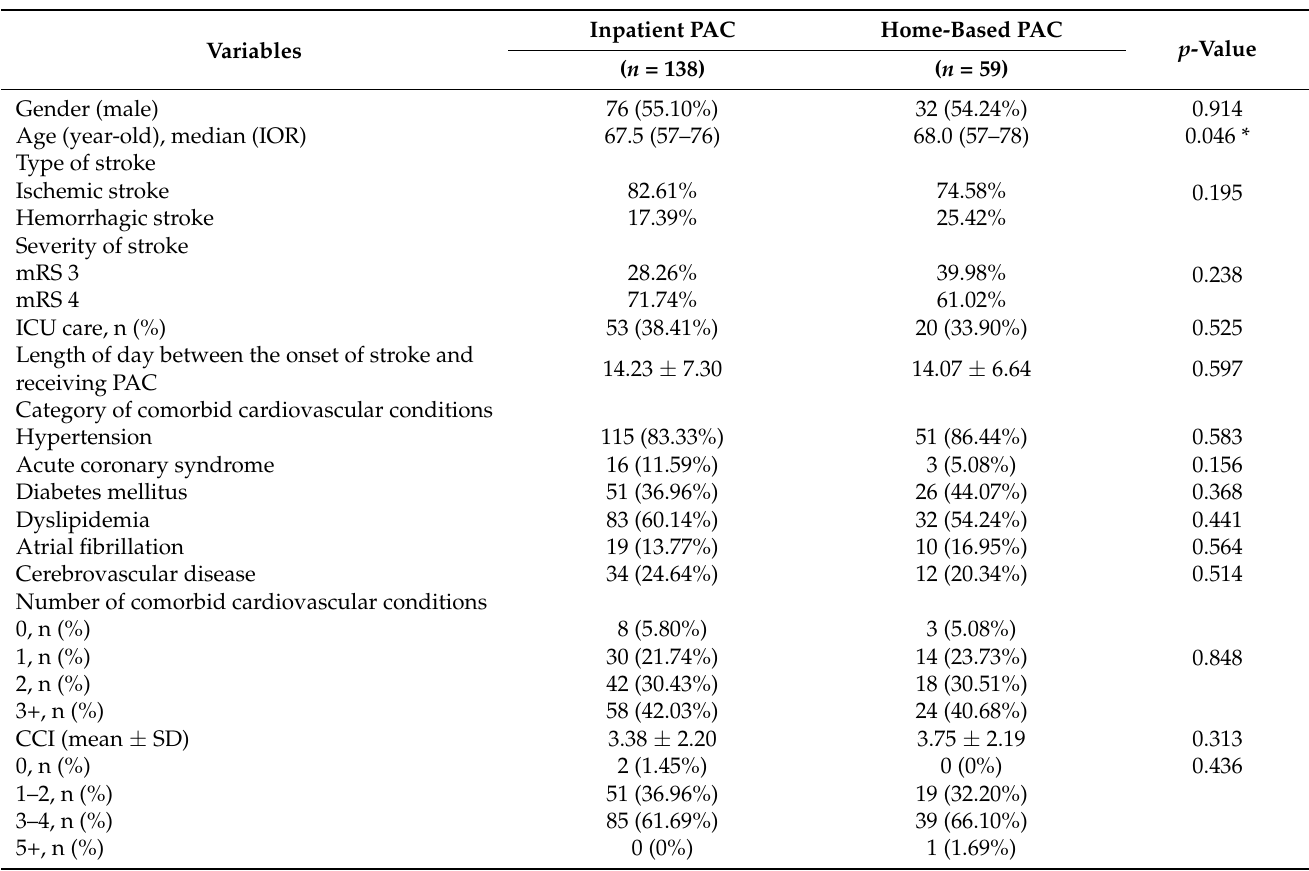
Table 1. Comparison of baseline demographic characteristics between the inpatient and home-based post-acute care (PAC)